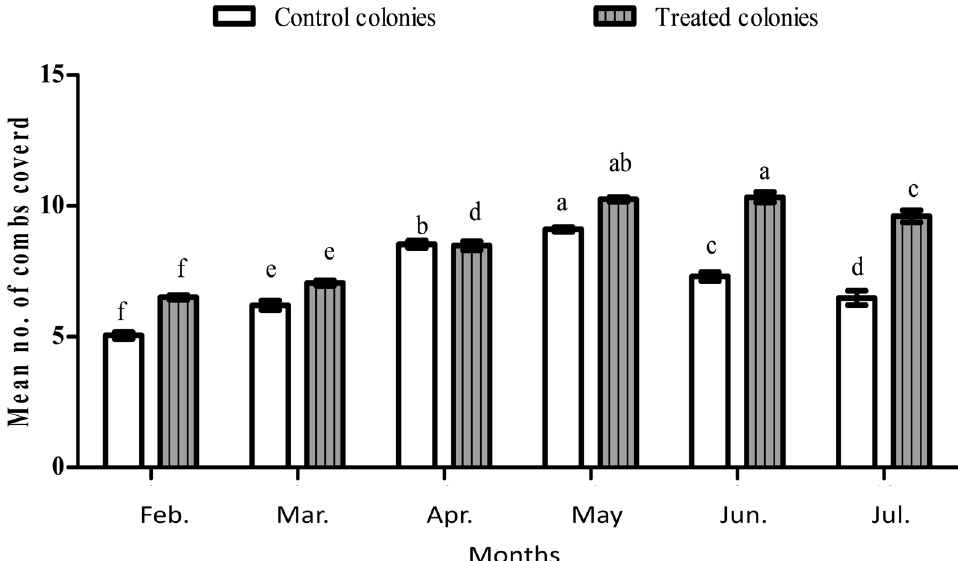
Fig. 5 The average ( SE) no. of combs covered with bees in control and treated ±